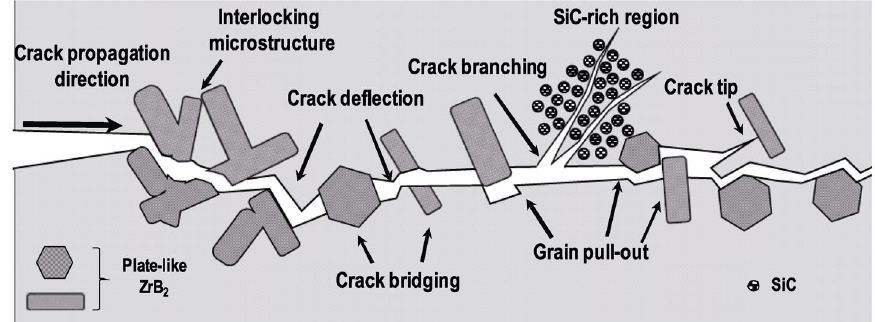
Fig. 9 Schematic of the self-toughening mechanism for the ZrB 2 –SiC composites prepared by reactive hot